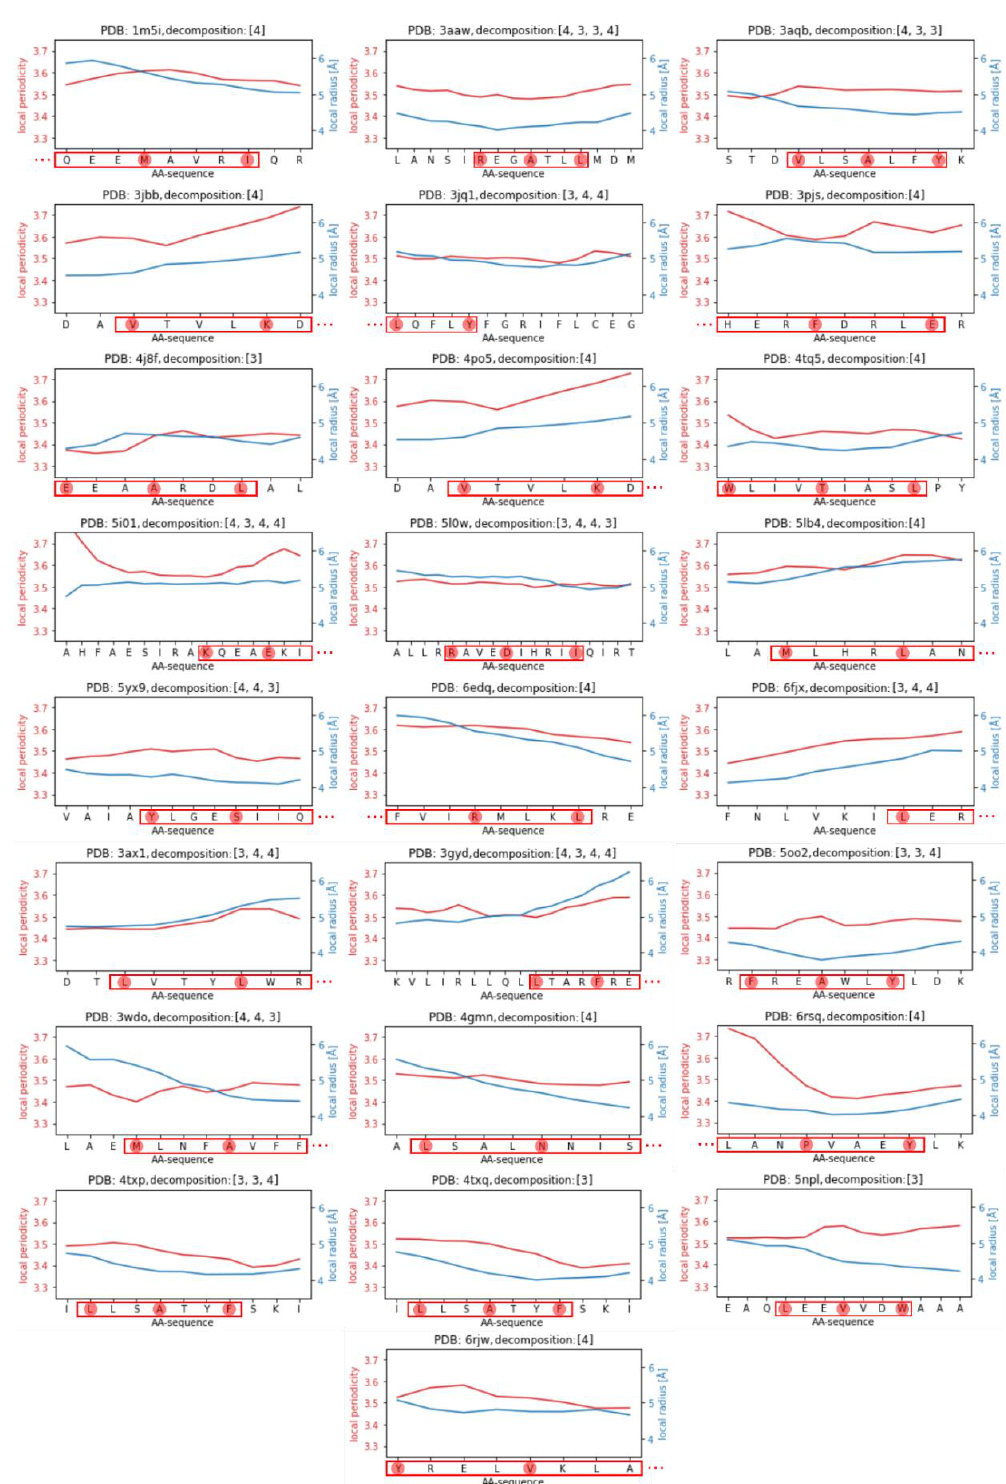
Figure 4. Local periodicity and local radius for the 25 identified demanding decompositions. The abscissa shows the amino acid sequence. The amino acids that are part of the 3 + 3 or 4 + 4 hydrophobic distance repeats within the decompositions are surrounded by a red box. Amino acids participating in interhelical contacts are further underlaid by a red circle. The three dots at the end of an amino acid sequence range indicate that the full coiled-coil sequence according to the CC+-database is deprecated in the CCdb.